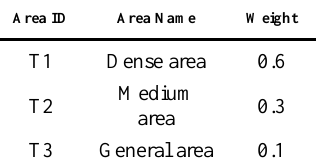
Table 4. Significance ranking of POI comprehensive